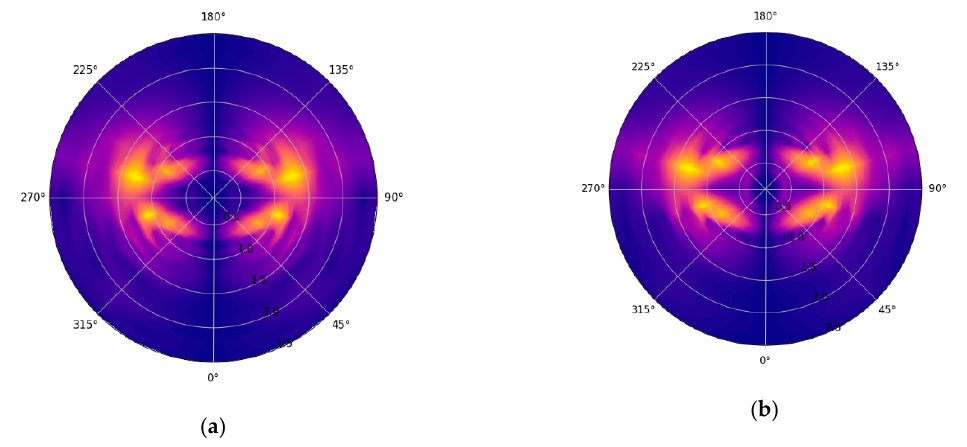
Figure 9. Torsional moment at ( a ) 0.25 L , and ( b ) 0.75 L .